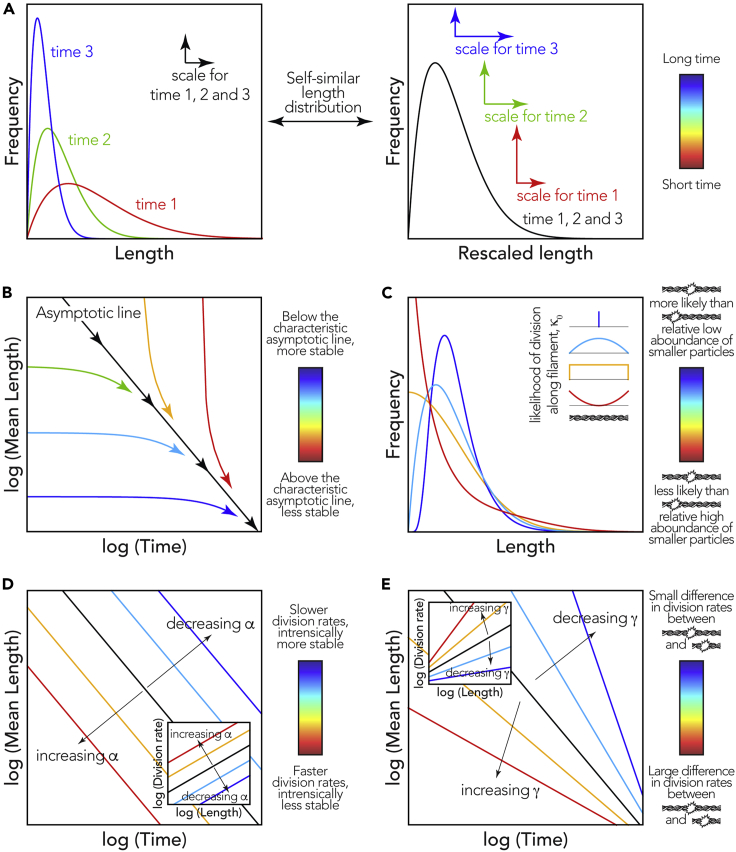
Illustration of The Key Insights Emerging from the Mathematical Analysis of the Division ModelThe behavior of the division equation Equation 1 is entirely and uniquely dictated by a set of three properties: α, γ, and κ0. Several key predictive insights emerged from the analytical solution of Equation 1 with regard to these three properties.(A) The three example length distributions in the left panel can be rescaled to show the same distribution shape in the right panel, illustrating the concept of self-similar length distributions.(B) After a period of time, the self-similar length distribution shape is reached. From this point, the reduction in the average length of the fibril length distribution can be described as a power law versus time. The decay of mean length of a sample is predicted to tend toward a straight line, the asymptotic line, when plotted on a log-log plot with the slope of the line representing −1/γ (black line in B, D, and E). The asymptotic line denoting mean fibril lengths decay also does not depend on the initial length distribution (colored lines in B).(C) The self-similar length distribution shape contains information about κ0, which describes how likely a fibril will divide in the middle versus shedding a small fragment from the edge. A κ0 indicative of fibril types that are more likely to divide in the middle will result in fibril length distributions with a distinct peak and low relative population of small fragments (dark blue and light blue curves). In contrast, κ0 indicative of fibril types and conditions that promote equal likelihood of division along the fibril or even favor shedding of small fragments from fibril edges will result in self-similar fibril length distributions that have a larger relative population of small fibril fragments (orange and red curves) compared with κ0 values favoring division in the center of the fibrils.(D and E) (D) and (E) illustrate how the black asymptotic line describing the decay of fibril lengths in (A) is dictated by the parameters α and γ, respectively. For each panel, the color bar to the right illustrates the different properties associated with the colors in the panel (e.g., division in the center versus at the edge of a fibril for (C), and division of a long versus a short fibril in (E)).